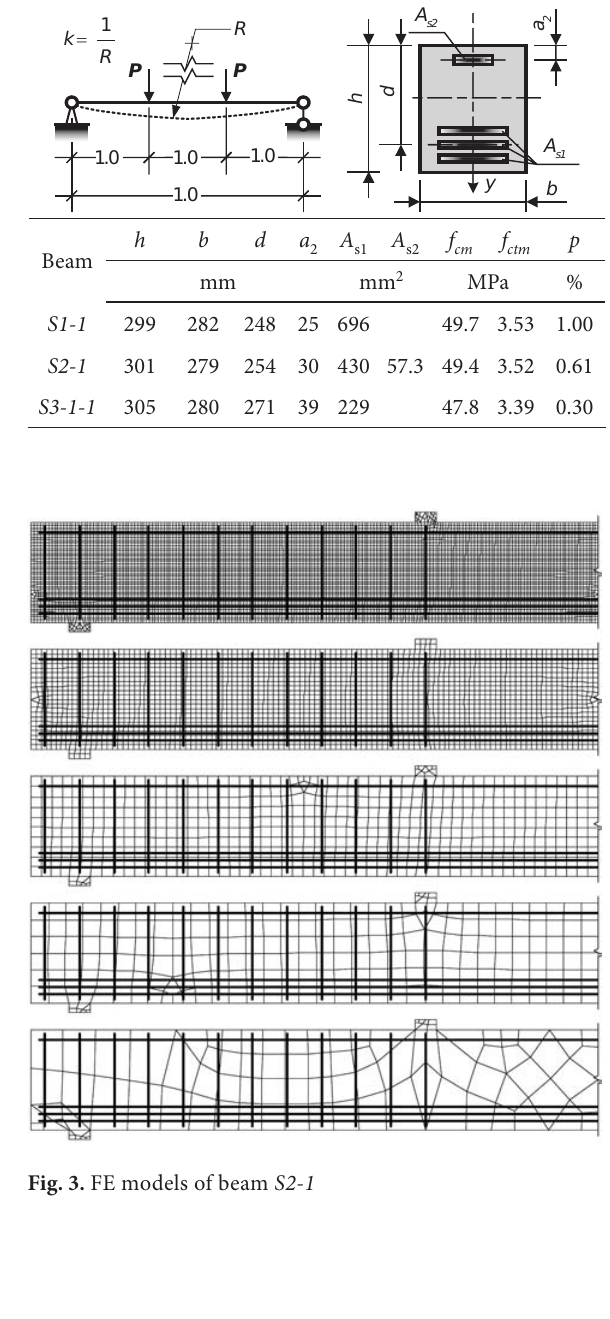
Table 1. Main characteristics of the test specimen